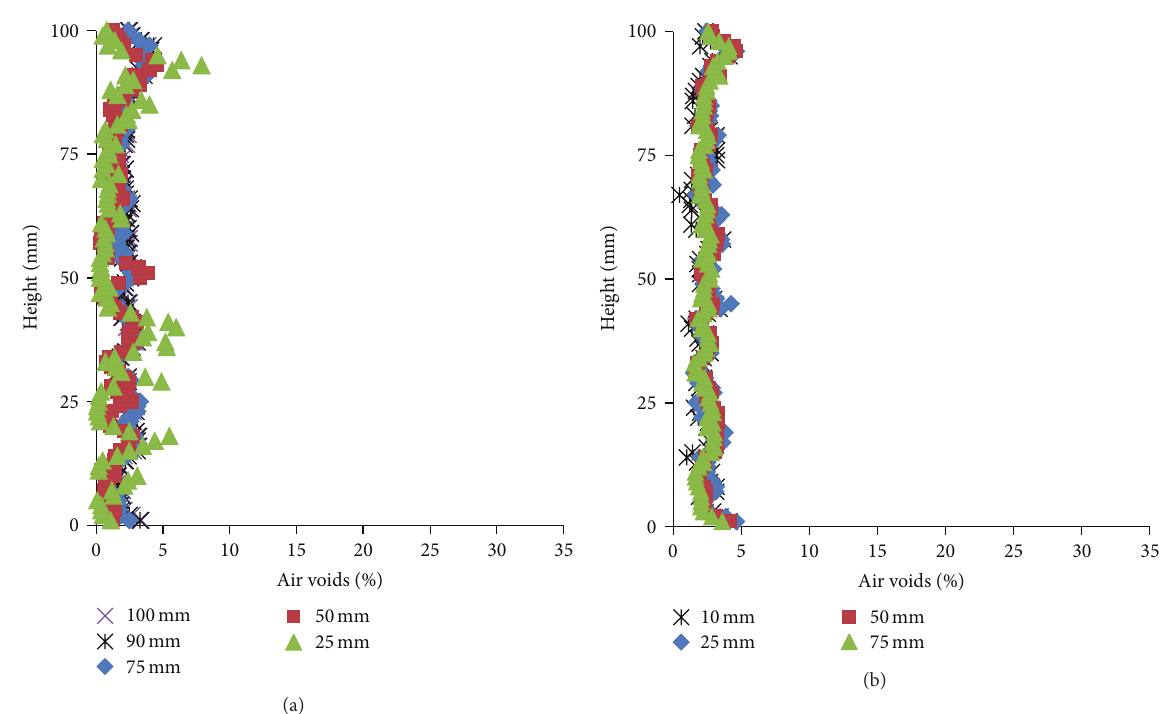
Figure 11: Air voids distribution within the virtual cut of (a) core and (b) ring for V-Mix with the air voids content of 2.6% and density of 2392 kg/m 3 .